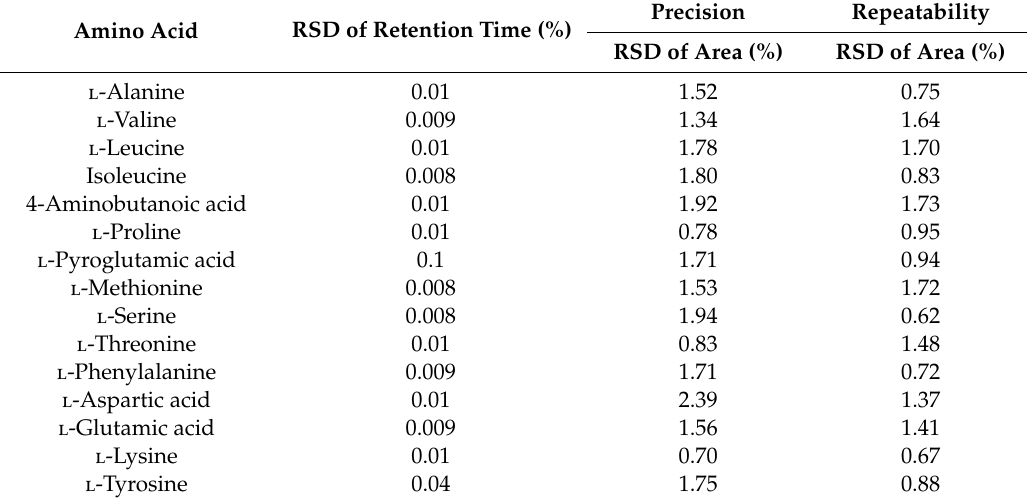
Table 3. Precision and repeatability of GC–MS